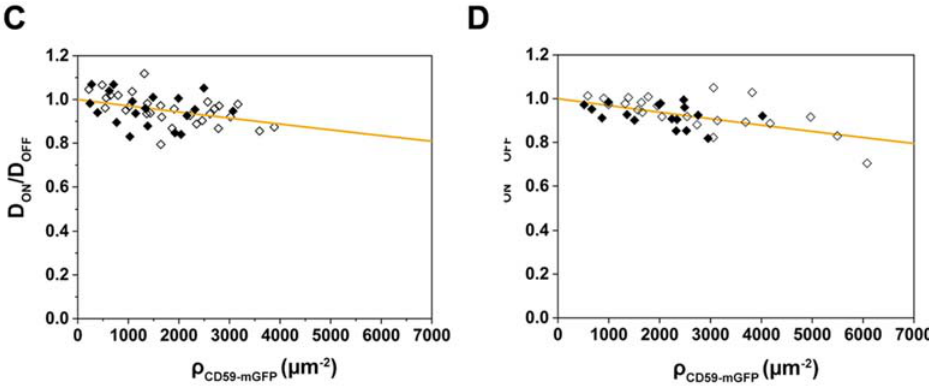
Figure 3. Dioleoyl-phosphatidylethanolamine(DOPE)-PEG-KK114 diffusion decreases with increasing CD59-mGFP density; the relative mobility of both lipids is independent of cell cholesterol levels. ( A ) Mean square displacements of DOPE-PEG-KK114 “ON” (orange) and “OFF” (black) CD59-mGFPI-enriched areas are plotted as a function of t lag for one representative cell. Diffusion coefficients were determined by fitting the function msd = 4Dt lag + 4 σ xy2 ; ( B ) Relative diffusion coefficients D ON /D OFF were determined for individual cells ( N = 28), plotted as a function of CD59-mGFP density, ρ CD59-mGFP , and fitted with Equation (2) (orange line). The gray circle indicates the cell shown in ( A ). Relative diffusion coefficients D ON /D OFF are plotted as a function of CD59-mGFP density (open diamonds) and after treatment with 1 U/mL cholesterol oxidase (closed diamonds) for ( C ) DOPE-PEG-KK114 ( N = 19) and ( D ) Chol-PEG-KK114 ( N = 17). Data from cholesterol-depleted cells were fitted with Equation (2) (orange